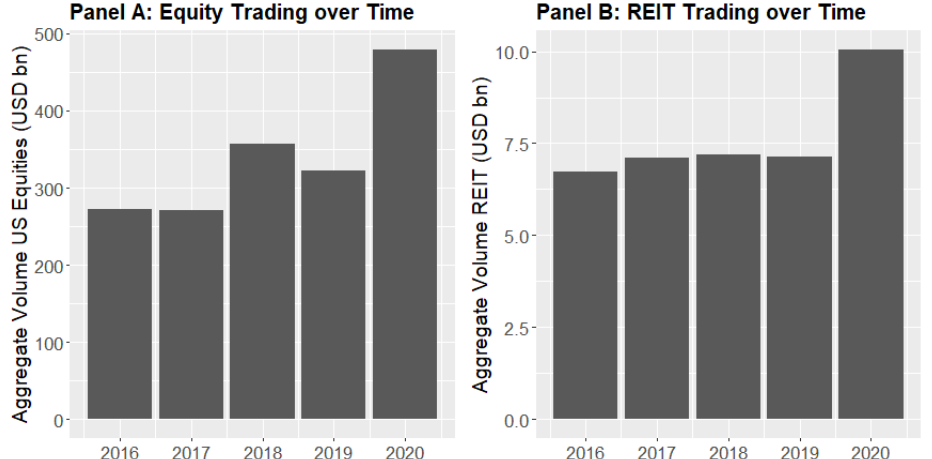
Figure 1. Trading patterns of US REITs and US equity market . Panel ( A ) shows the trading volume in USD billion between 2016 and 2020 in the US equity market as reported by SIFMA. Panel ( B ) shows the REIT trading activity in our sample in USD billion between 2016 and 2020. A high number indicates high trading activity.